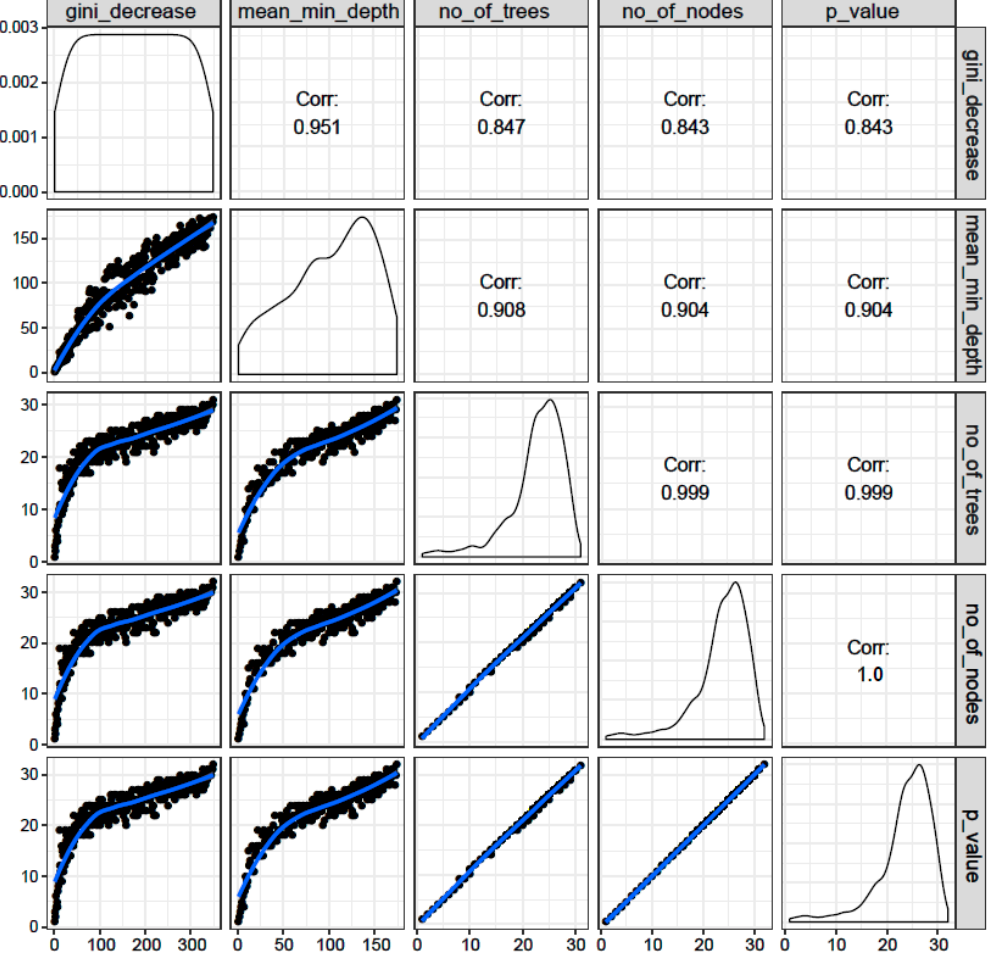
Figure 4. Illustration of rankings of variables based on any of the two Random Forest (RF) parameters of importance (panels in the lower triangle of the grid showing distribution of rankings of all predictor variables with black dots along a blue trend line) as well as correlation coefficient across rankings of any two parameters (panels in the upper triangle of the grid). It is shown that all RF parameters of importance were found to have very high correlations among each other, suggesting high reliability of each of these parameters to rank the importance of variables for group classification.